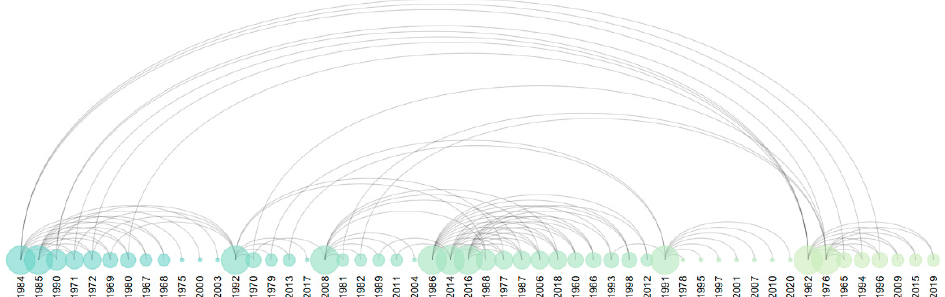
Figure 5. Similar years corresponding to the sample year of the dry season. Note: The arcs in the figure connect the sample year and its corresponding similar years. The size of the circle indicates the number of occurrences of the year.